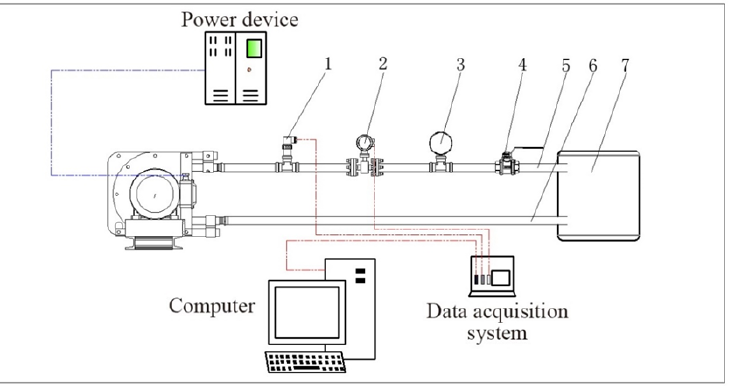
Figure 6. Scheme of the test rig. 1. Pulsating pressure sensor; 2. electromagnetic flowmeter; 3. pressure gauge; 4. valve; 5. outlet pipe; 6. inlet pipe; 7. water